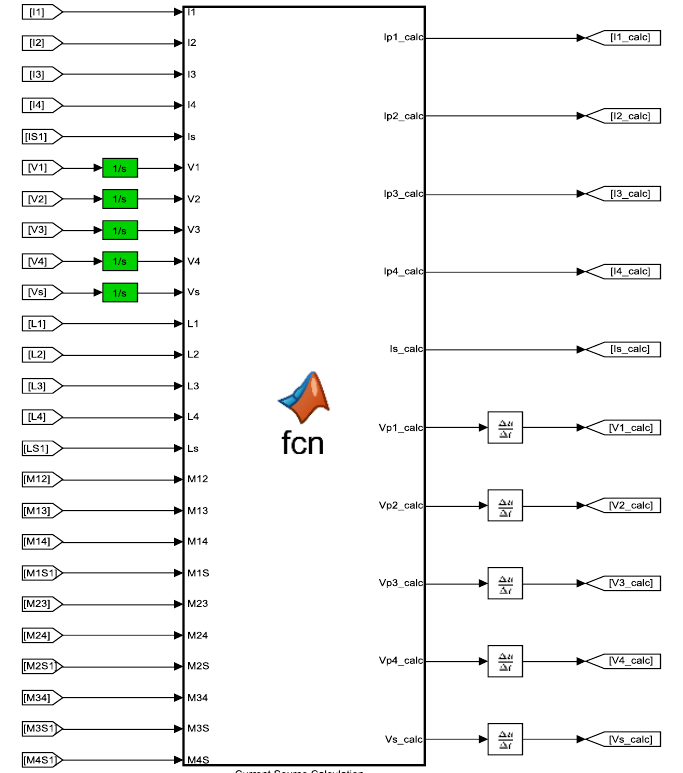
Figure A3. Each coil is modeled as a current source.